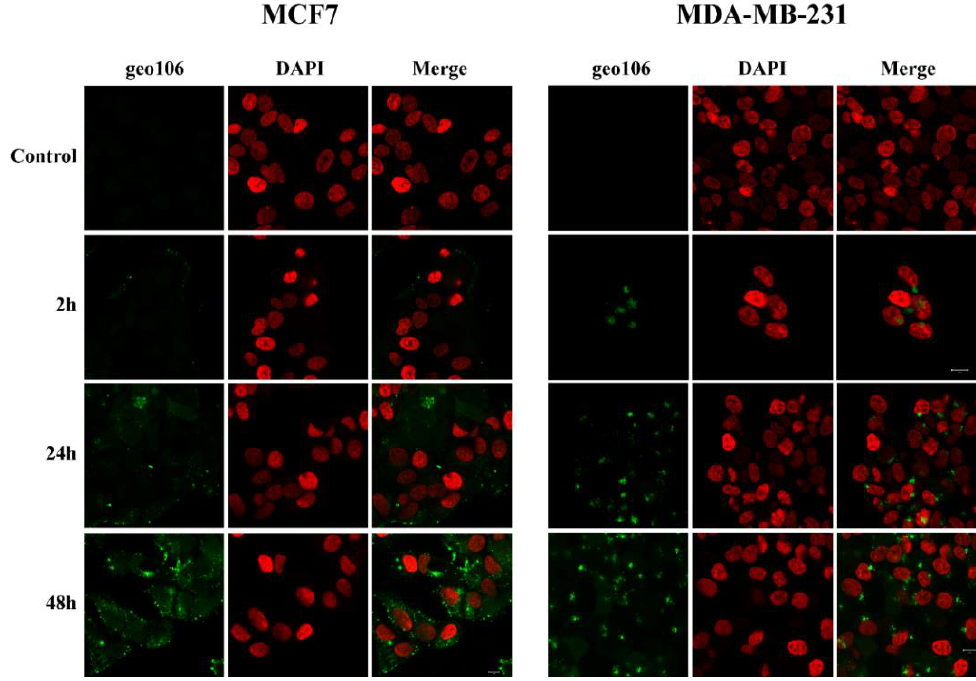
Figure 7. Confocal microscopy images of MCF7 and MDA-MB-231 cells after incubation with 5 µ M of geo106 for 2, 24 and 48 h, respectively. Cells were fixed with 4% paraformaldehyde. DNA was stained with DAPI (pseudo color red). Cells were visualized with a Zeiss LSM 780 confocal microscope using the Zen 2011 software.